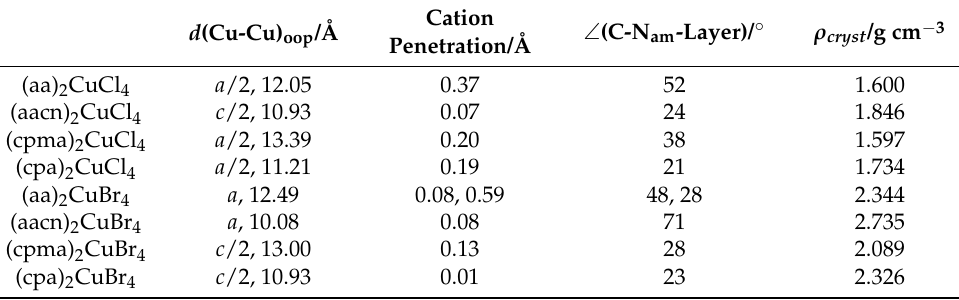
Figure 2. Top and side views of hydrogen bond anchoring of organic cation in ( a ) cpma 2 CuCl 4 and ( b ) cpma 2 CuBr 4 . Table 2. Cation-dependent structural parameters observed in the crystal structures of alkylammo- nium tetrahalocuprates prepared in this work. d (Cu-Cu) oop represents interlayer distance, cation penetration represents distance between the ammonium nitrogen atom and a plane spanned by axial halogenide ions [13], ∠ (C-N am -layer) represents the angle between C-NH 3+ bond and plane spanned by metal ions, and ρ cryst represents density of the crystal calculated from structural